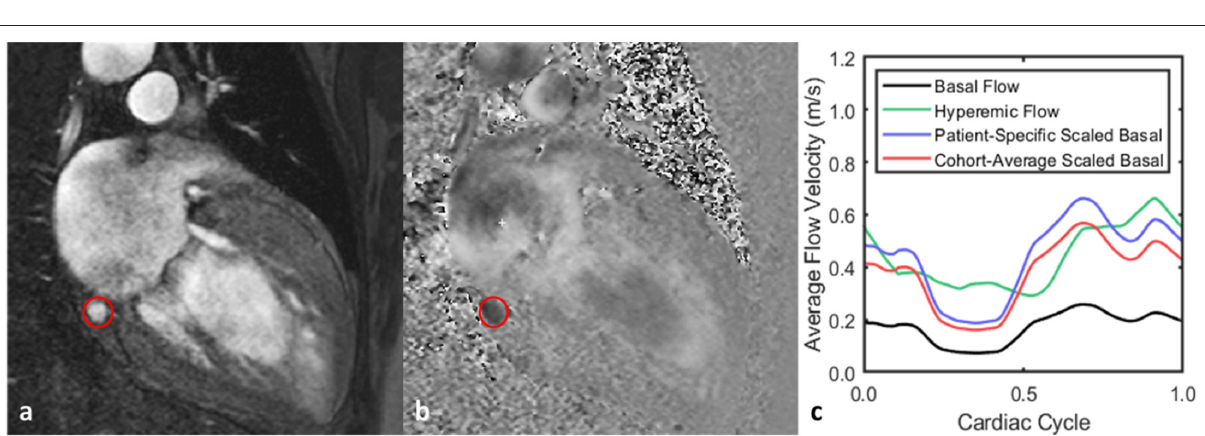
FIGURE 4 | Representative flow waveform measurement for one patient. (a,b) Magnitude and phase images acquired from PCMR acquisition with the coronary sinus outlined. (c) Both the basal and hyperemic flows were acquired using PCMR, and the basal flow was then scaled by a range of CFR values. When the basal flow is scaled by the patient-specific CFR—2.8—, the time-average flow rate is the same for both it and the hyperemic flow. Scaling the basal flow by the cohort-average CFR—2.2—produces the same basal waveform but with a different time-average flow rate from the hyperemic